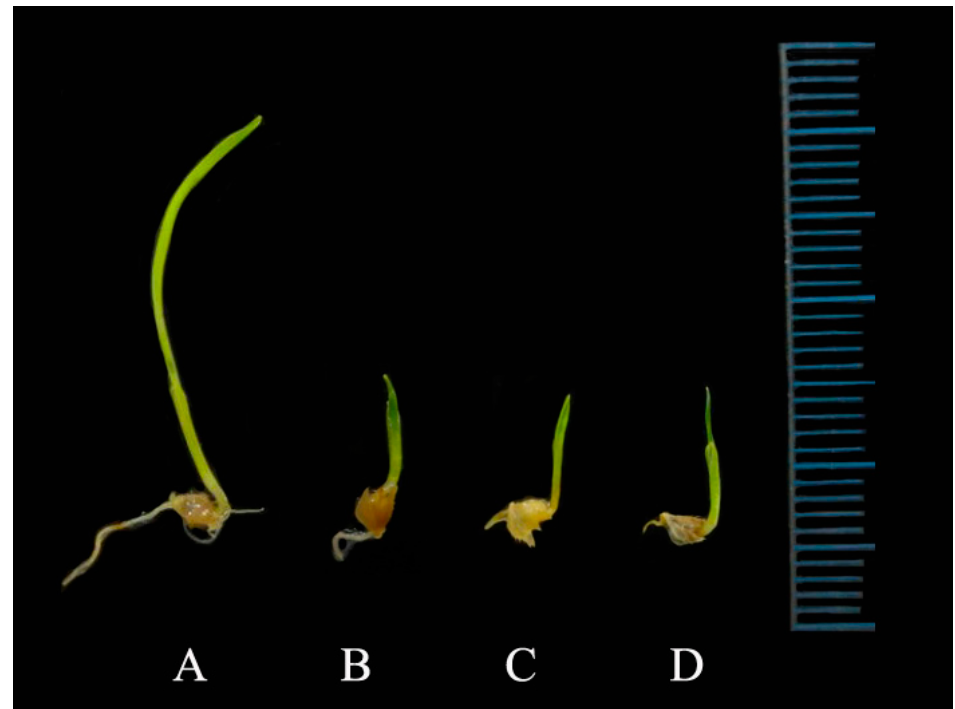
Figure 9. Morphological characterization of seed germination of E. oryzicola according to treatment of isolated compounds from rice ( O. sativa ) after 14 days. ( A ) DW+ 10% MeOH, ( B ) compound 1 500 μ M, ( C ) compound 2 500 μ M, ( D ) compound 3 500 μ M. Table 6. Effect of isolated compounds from rice ( O. sativa ) on shoot and root length of E. oryzicola after 7 days. Sample